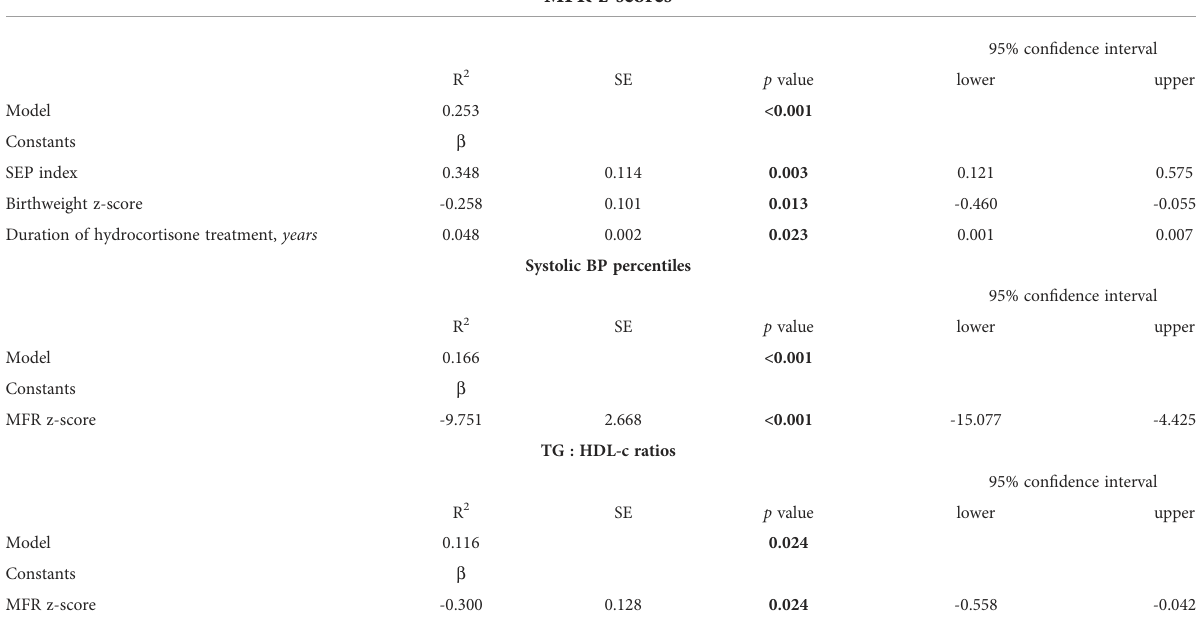
TABLE 4 Stepwise linear regression models in the NCCAH study